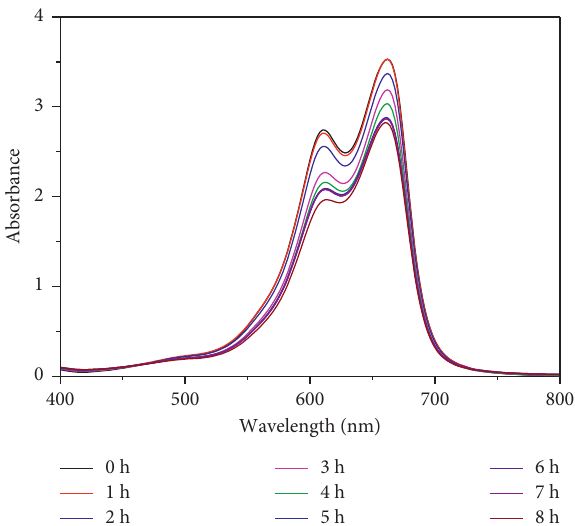
Figure 5: Absorbance spectrum of dye versus wavelength.